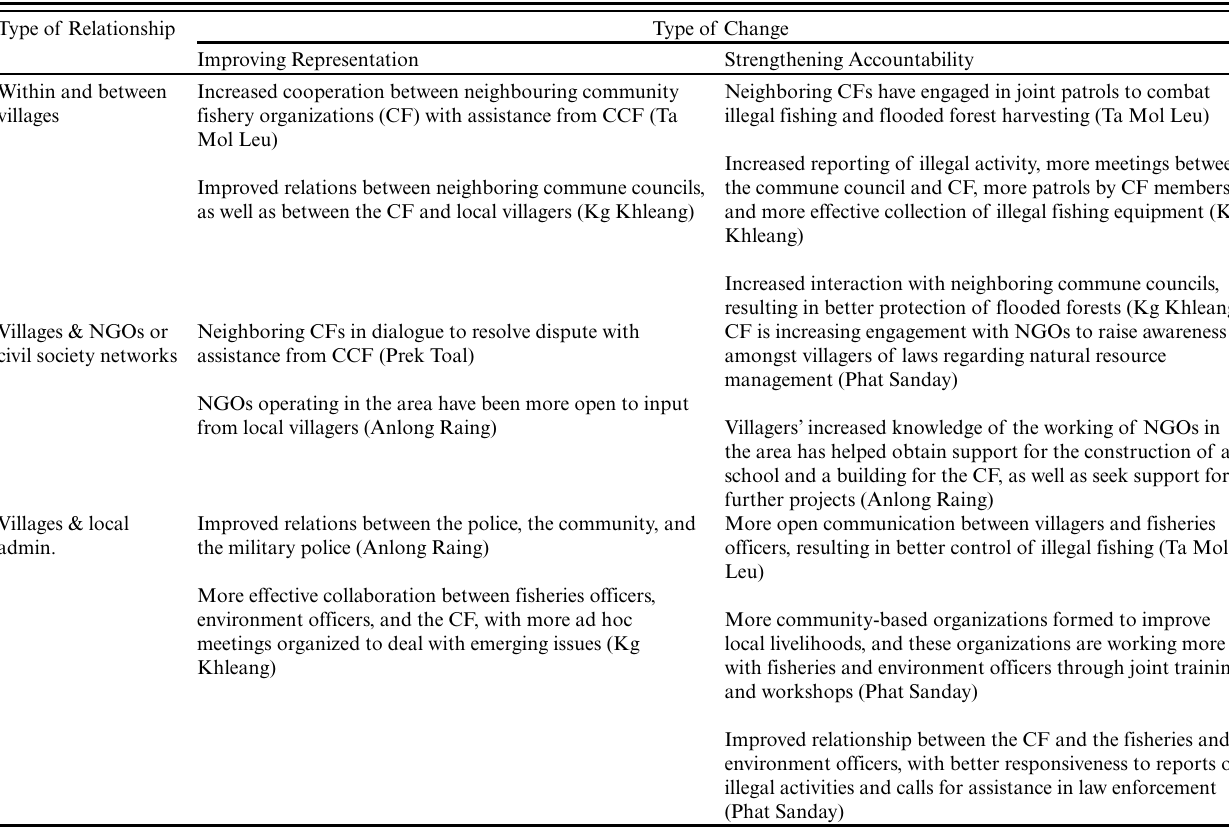
Table 1 . Additional outcomes (case study sites in